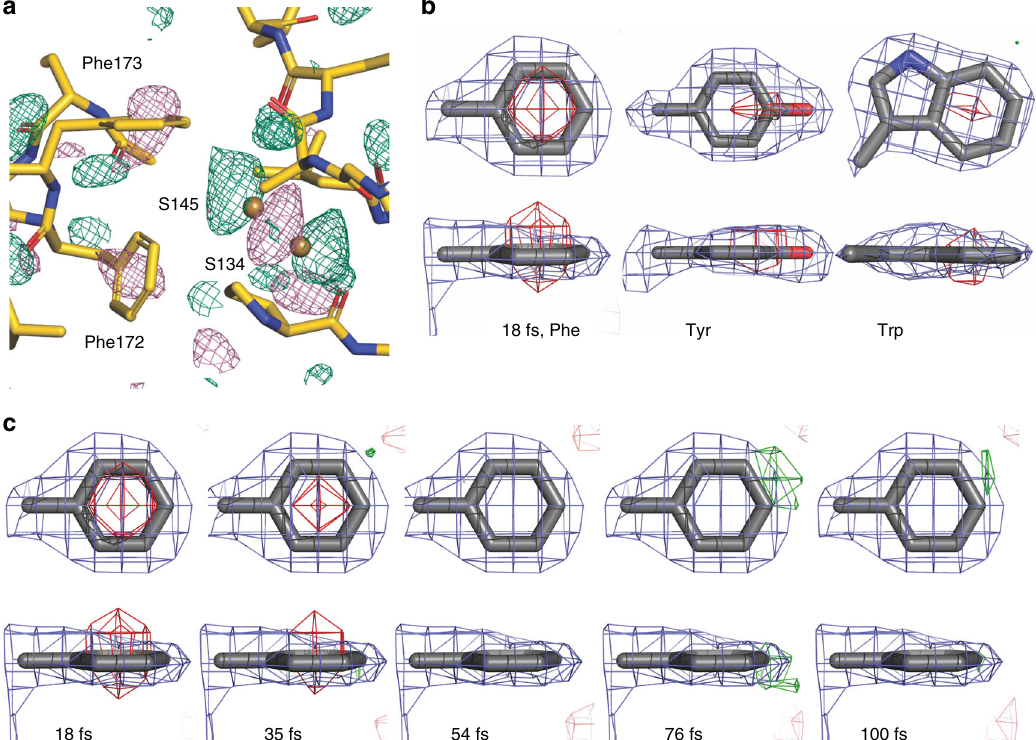
Fig. 3 Changes in aromatic side chains. a The isomorphous difference electron density map (F obs(18fs) – F obs(single pulse) ) 29 of thaumatin shows peaks ( − 3 σ (pink) and + 3 σ (green)) in the center of phenyl rings. In addition, there are changes around the adjacent elongated Cys145-Csy134 disul fi de bridge and the backbone carbonyl oxygen atoms. b Averaged difference density (18 fs time delay point) of all phenylalanines (11), tyrosines (8) and tryptophan (3) side chain in thaumatin. c The difference electron density maps averaged over all phenylalanine residues shows that the negative difference is highest after 18 fs and no longer visible at 54 fs. It is unclear whether this latter observation is an effect of data